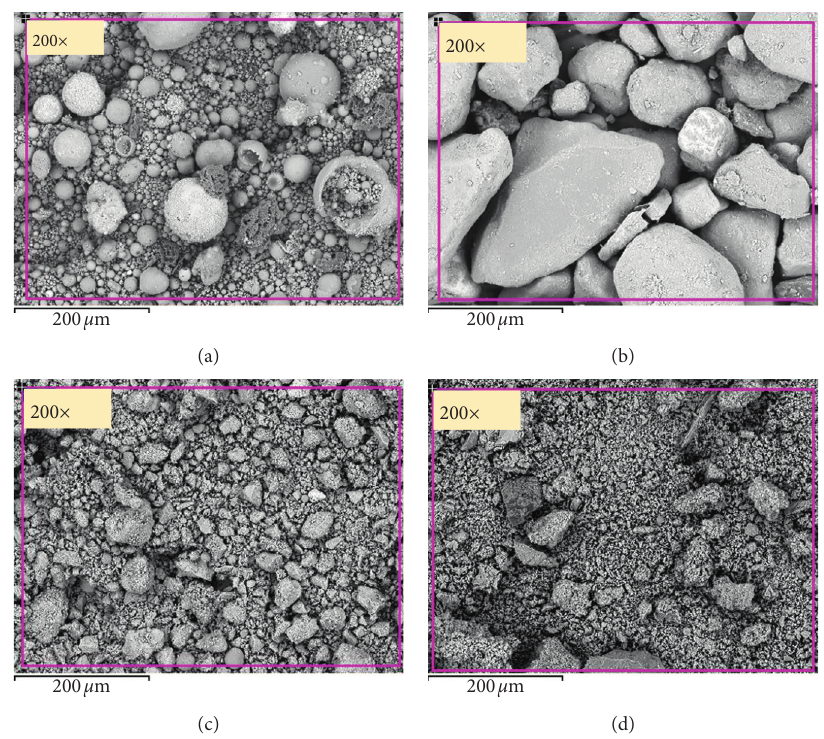
Figure 2: SEM/EDS analysis of the raw materials. (a) Fly ash. (b) Aeolian sand. (c) Cement. (d) Quicklime.